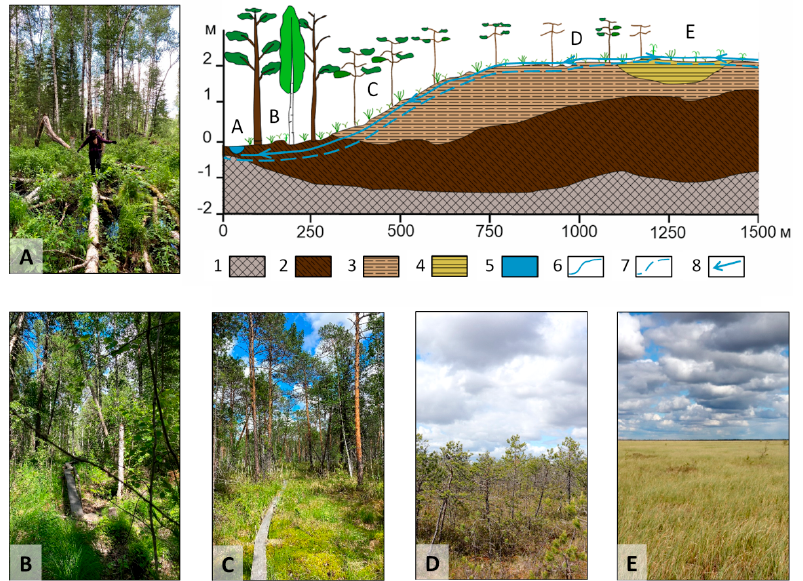
Figure 2. The aquatic continuum of the study site represented by Klyuch River ( A ), waterlogged mixed forest ( B ), tall ryam (pine − shrub − sphagnum phytocenosis with high pine trees) ( C ); low ryam (pine − shrub − sphagnum phytocenosis with low pine trees) ( D ); open sedge − sphagnum fen ( E ). The numbers on the diagram represent the following: 1—sedge or sedge − wood mainly highly decomposed peat (sapric); 2—wood − grass and wood − sphagnum medium decomposed peat (hemic); 3—sphagnum (dominated by S. magellanicum , and S. fuscum ), grass − sphagnum, pine − cotton and pine shrub mostly undecomposed and medium decomposed peat (fibric and hemic); 4—sphagnum and sedge − sphagnum undecomposed peat (fibric); 5—mire stream (Klyuch River); 6—water level (20.05.2015/18); 7—water level (20.08.2015/18); 8—water flow in May (surface streamflow is absent during summer-autumn drought period).